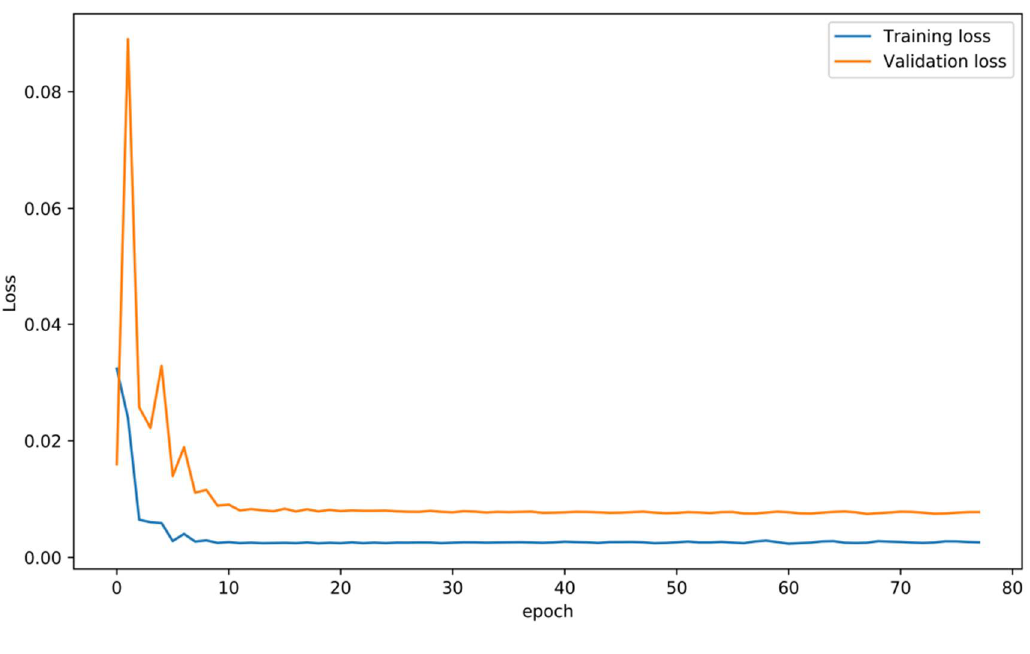
Figure 5. Model training vs. validation loss for LSTM.